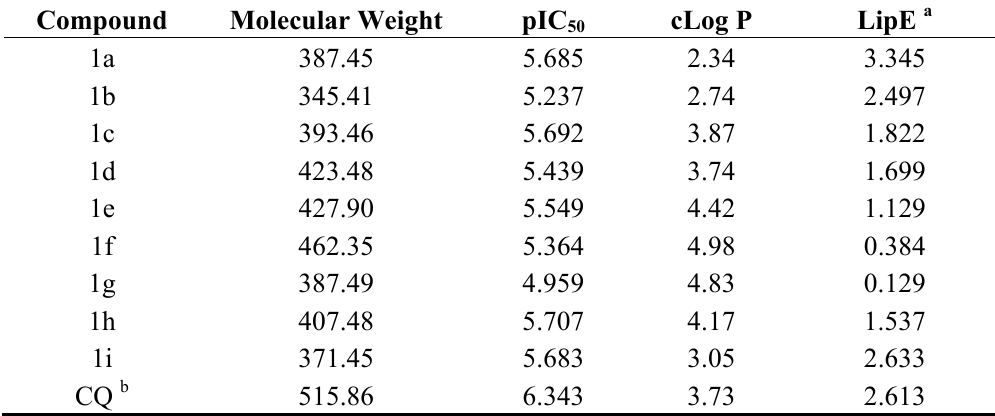
Table 2. Physicochemical properties of 4-methoxychalcone derivatives 1a – i . Compound Molecular Weight